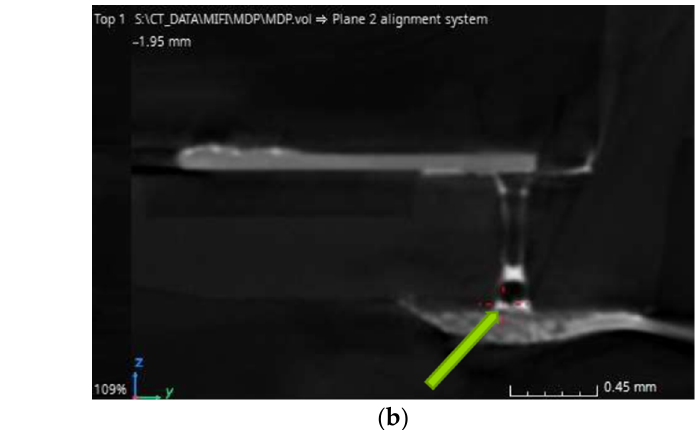
( c ) Figure 6. The results of laser cutting the bottom part of a metal–ceramic package on the via hole line: ( a ) the bottom part of a metal–ceramic package, cut into two parts by a laser; ( b ) cross-section of the